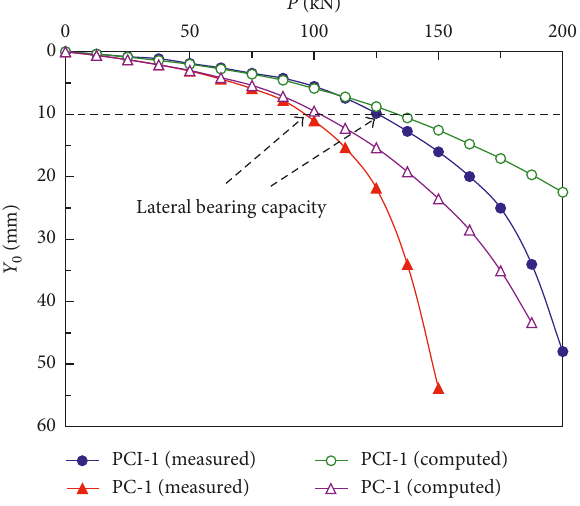
Figure 4: Comparisons between the measured and computed P - Y curves for pile PCI-1 and pile PC-1.